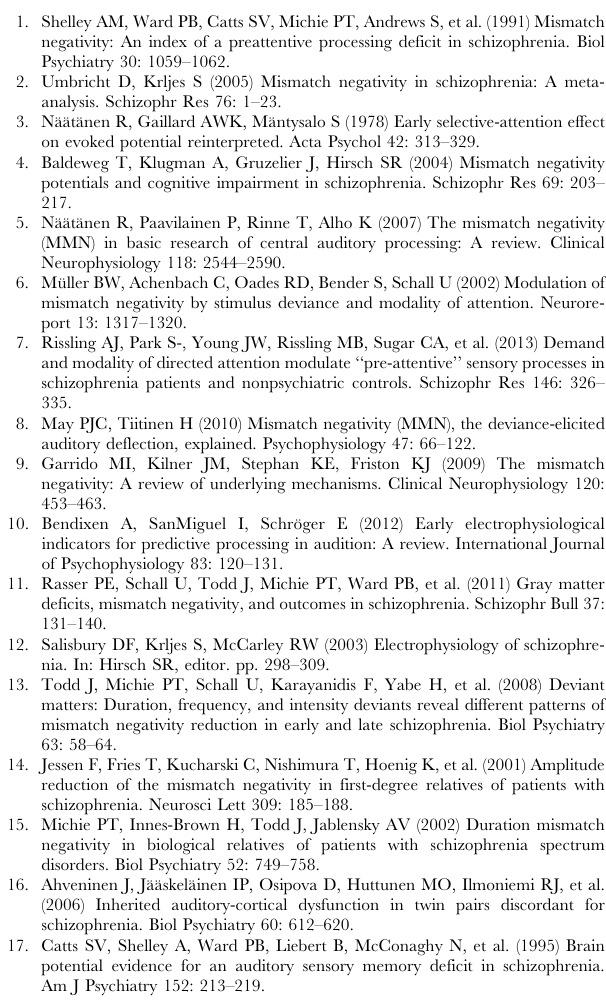
Table S1 Spearman rank correlations (p-values) between neuro- psychological measures and MMN parameters in